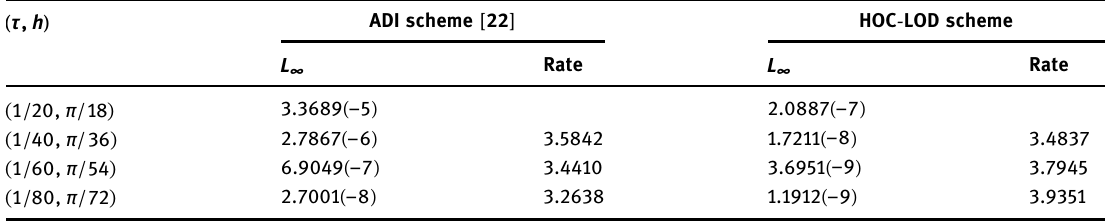
Table 8: L ∞ error when